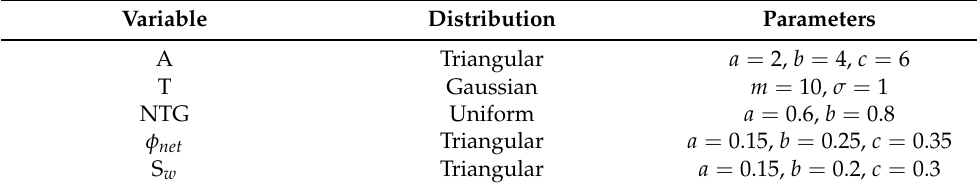
Figure 7. Four sets of samples with n = 20 realizations generated by each sampling technique in a two-dimensional sampling space where the random variables are positively correlated. Table 1. The parametric distributions and their parameters used for each OOIP